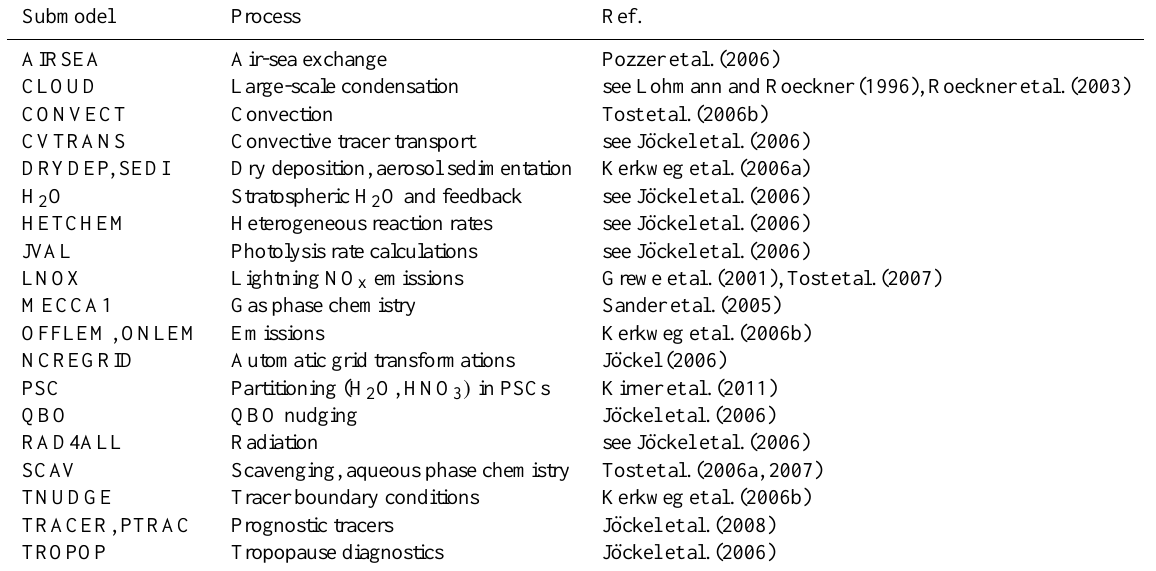
Table B1. Applied processes and respective submodels of EMAC. Submodel Process Ref. AIRSEA Air-sea exchange Pozzer et al. (2006) CLOUD Large-scale condensation see Lohmann and Roeckner (1996), Roeckner et al. (2003) CONVECT Convection Tost et al. (2006b) Convective tracer transport see J¨ockel et al. (2006) Dry deposition, aerosol sedimentation Kerkweg et al. (2006a) Stratospheric H 2 O and feedback see J¨ockel et al. (2006) see J¨ockel et al. (2006) see J¨ockel et al. (2006) Lightning NO x emissions Grewe et al. (2001), Tost et al. (2007) Sander et al. (2005) Kerkweg et al. (2006b) J¨ockel (2006) Kirner et al.